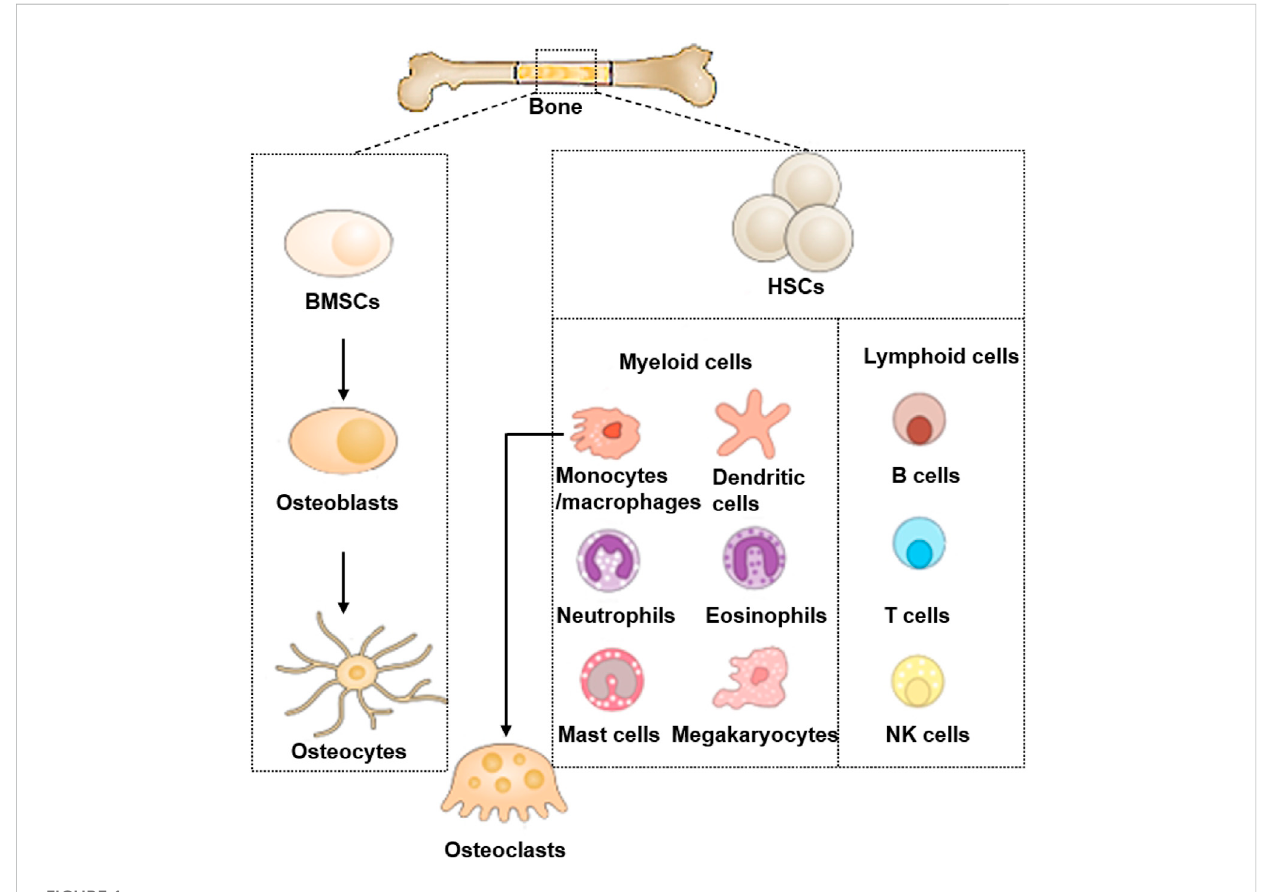
FIGURE 1 Bone cells and immune cells in